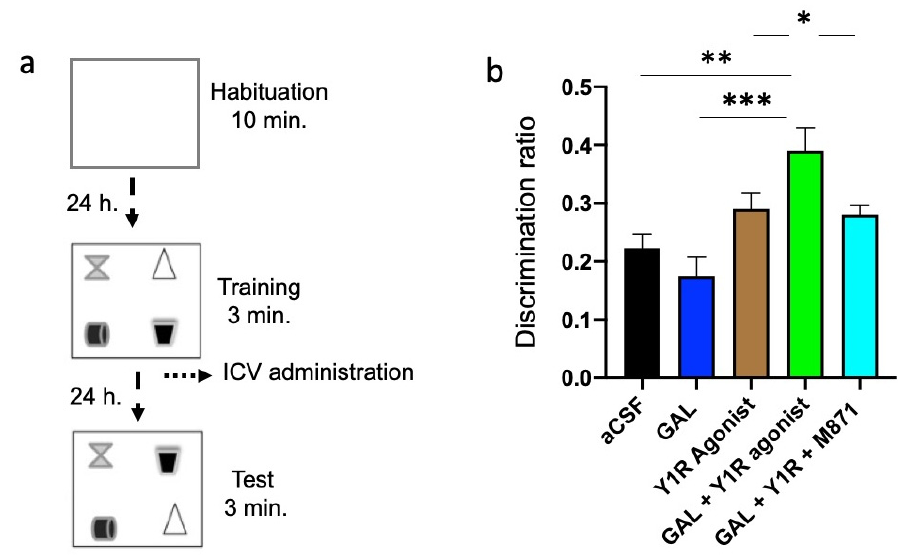
Figure 5. Spatial memory assessment after GAL and the Y1R agonist alone and combined in the object-in-place memory task. ( a ) Schematic representation of the trials completed in the object-in- place task. The animals performed the task in three phases, divided 24 h from each other, where they explored freely for ten minutes in the habituation phase without objects, three minutes in the training phase with four different objects, and finally, three minutes in the test phase with two of the objects with the exchanged position. To achieve memory consolidation, the pharmacological treatments were administered intracerebroventricularly (icv) to the different groups of animals 24 h before the testing phase. ( b ) Performance on the object-in-place task showing the ability of rats to discriminate the exchanged objects at 24 h post-training after the icv administration of GAL in combination with the Y1R agonist. An improvement in the object-in-place performance was observed after GAL and the Y1 agonist co-administration following a 24 h delay. Besides, this effect is counteracted by the GAL 2 receptor (GALR2) antagonist M871. Data are presented as the mean ± SEM of the discrimination ratio on the test phase. n = 6 animals in each group. * p < 0.05 vs. Y1R agonist and GAL + Y1R + M871; ** p < 0.01 vs. aCSF; *** p < 0.001 vs. GAL according to one-way ANOVA (F4, 25 = 3.56) followed by Newman–Keuls post-hoc test. Statistical values are presented in Supplementary Table S1. Abbreviations: aCSF = Control (artificial cerebrospinal fluid), GAL = galanin (3 nmol), Y1R agonist = Y1R receptor agonist [Leu 31 -Pro 34 ]NPY (3 nmol), GAL + Y1R = co-administration of GAL and Y1R, GAL + Y1R + M871 = co-administration of GAL, Y1R, and GALR2 antagonist M871 (3